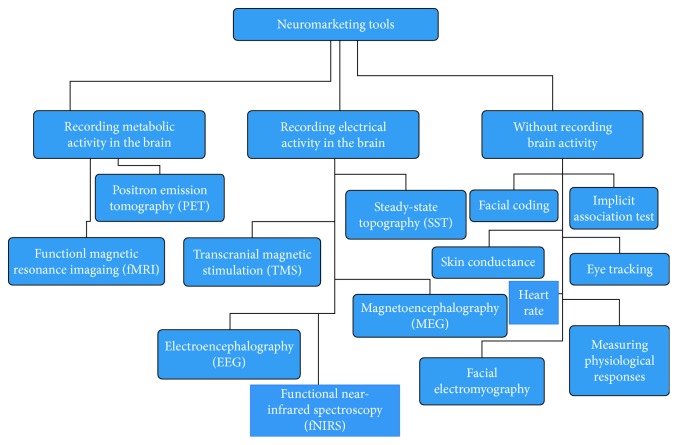
Classification of neuromarketing tools modified from the study of Bercea, 2013.